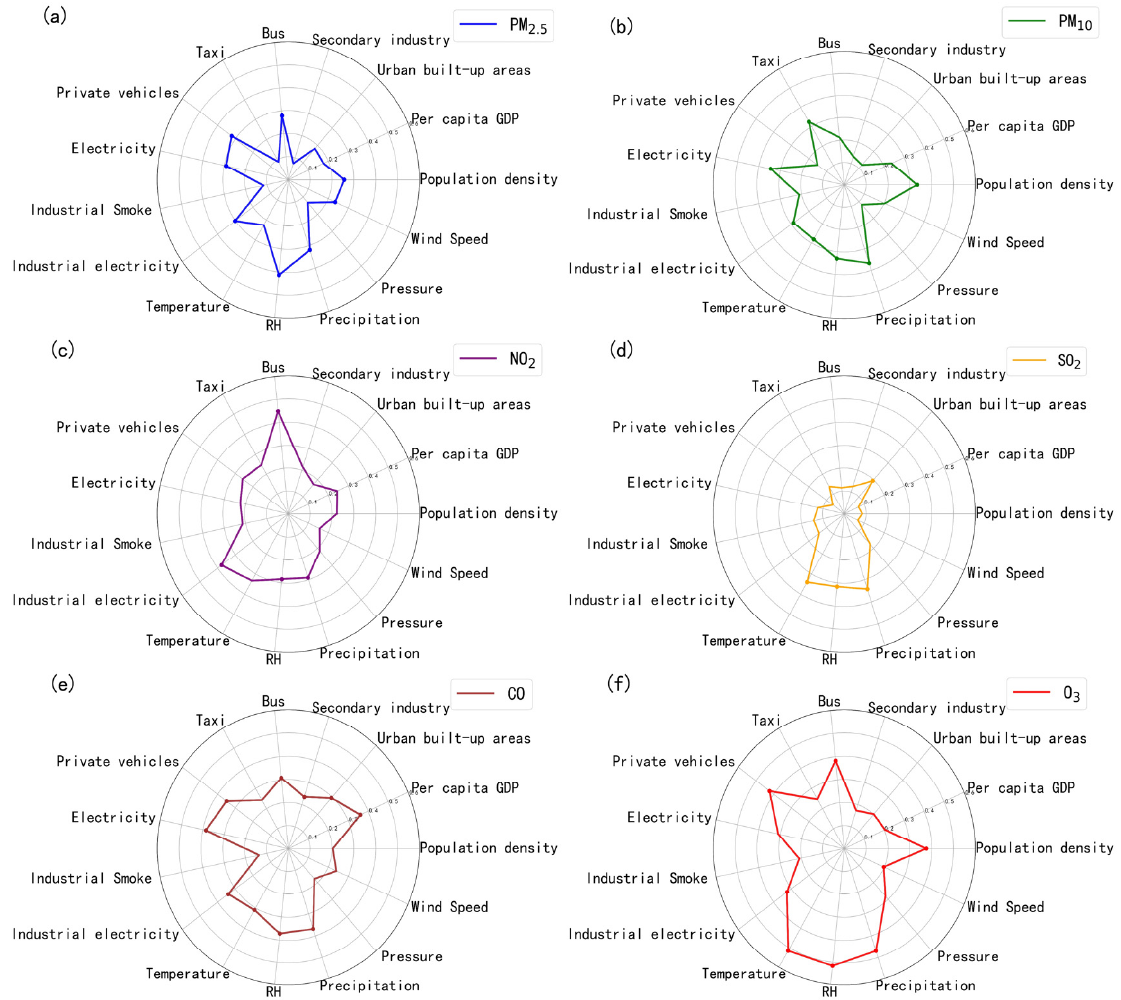
Figure 6. Natural and socio-economic factors on the variation of PM 2.5 , PM 10 , NO 2 , SO 2 , CO and O 3 during lockdown: ( a ) PM 2.5 , ( b ) PM 10 , ( c ) NO 2 , ( d ) SO 2 , ( e ) CO, ( f ) O 3.